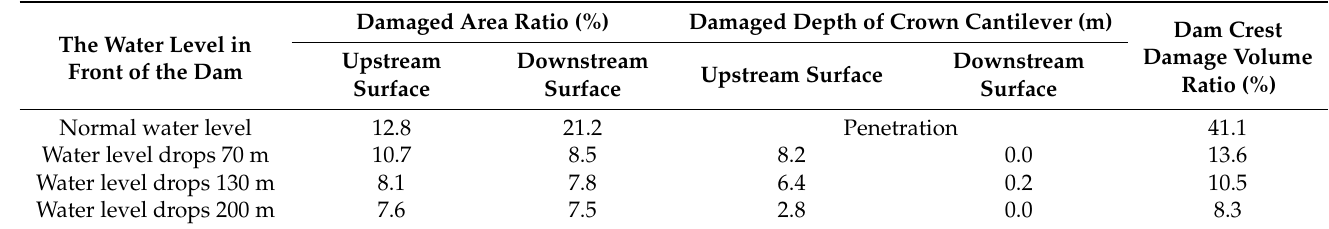
Table 6. Failure of the arch dam body due to varying water levels in front of the dam.